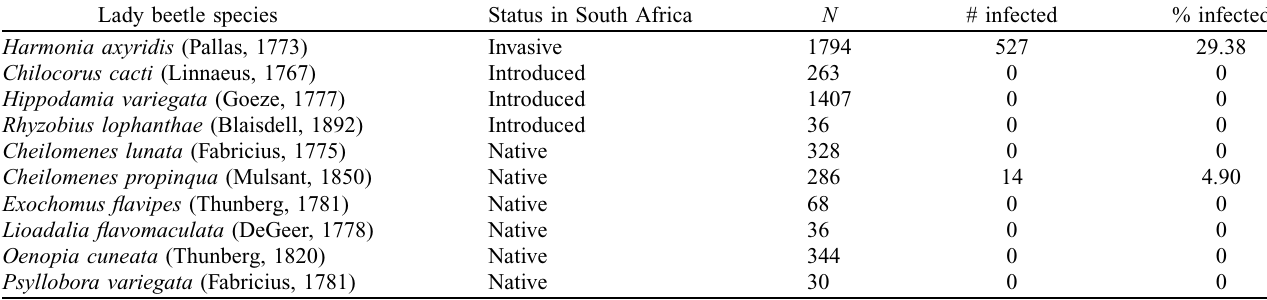
Table 1. Ladybirds collected in Stellenbosch, South Africa, in the period 2013–2015, with indication of number of collected specimens ( N ) and infection prevalence (in numbers and